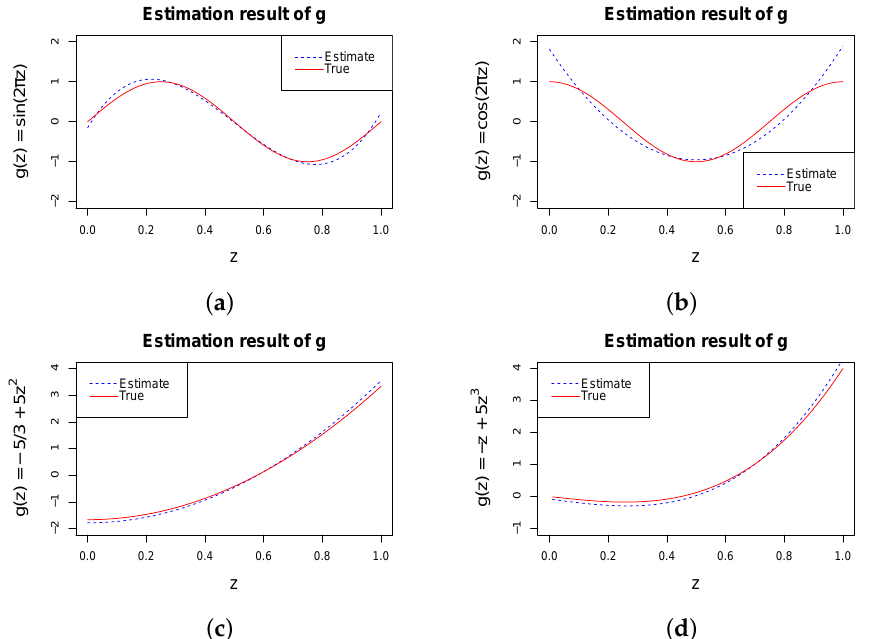
Figure 2. Estimated g with β = 0 and τ = 0.6; the solid red lines represent the real functions and the dashed blue lines show the estimated functions. ( a ) g ( z ) = sin ( 2 π z ) ; ( b ) g ( z ) = cos ( 2 π z ) ; − 5 z 2 ; ( d ) g ( z ) = − z + 5 z 3 ( c ) g ( z ) = 5 3